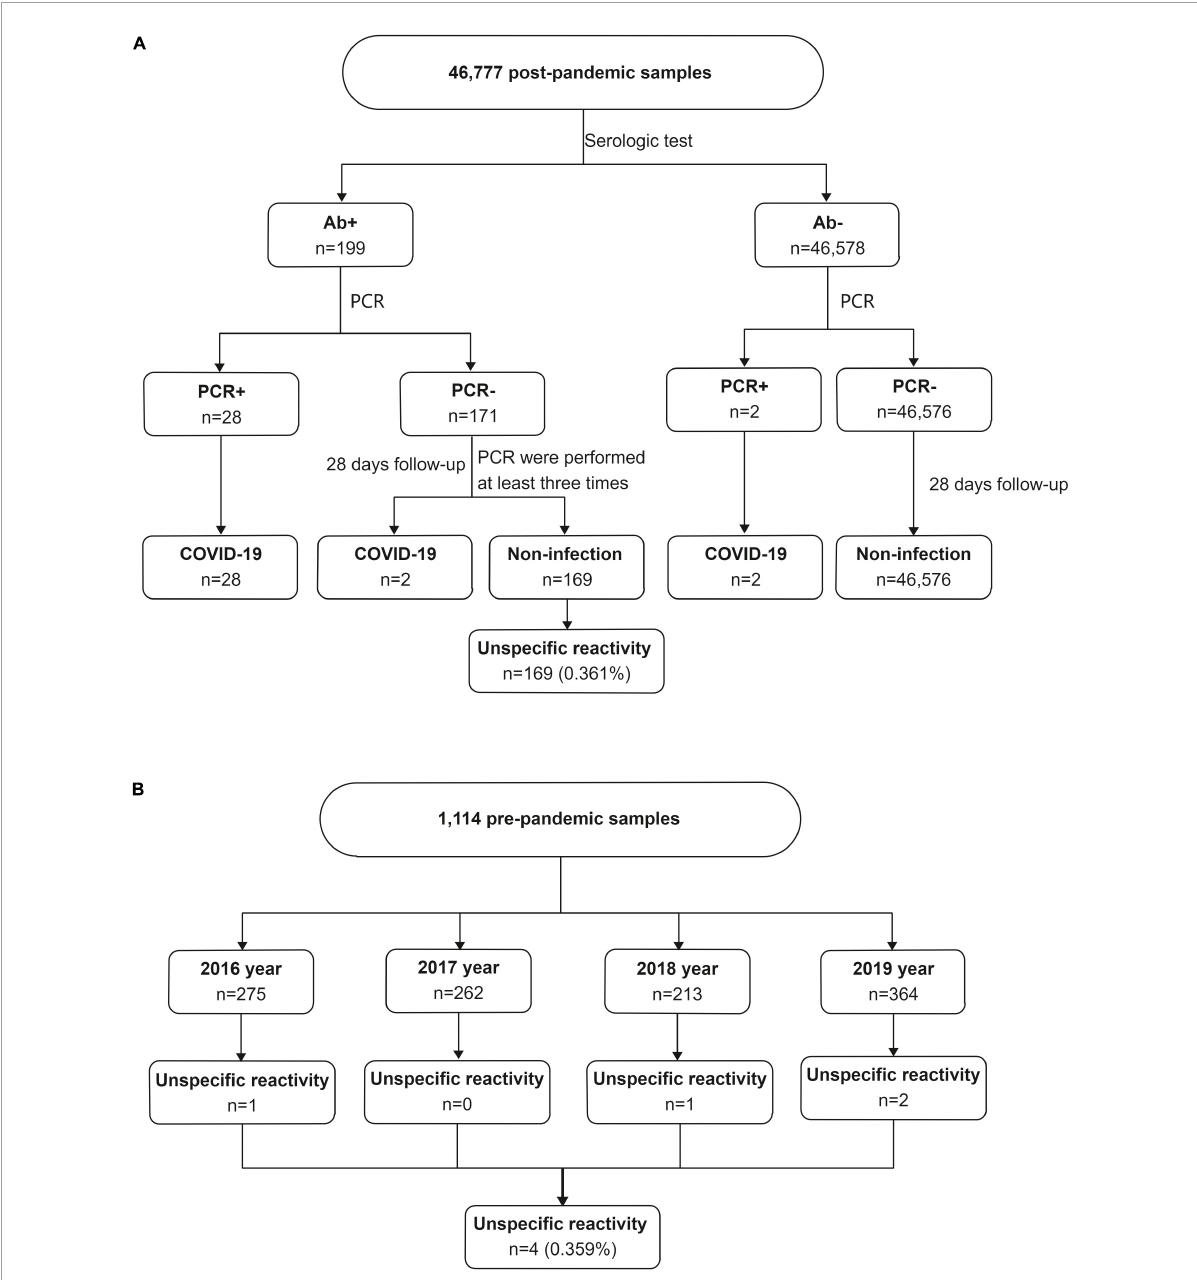
FIGURE1 The unspecific reactivity in anti-SARS-CoV-2 total antibody testing. (A) The unspecific reactivity in 46,777 post-pandemic subjects who were screened for SARS-CoV-2 infection, (B) the unspecific reactivity in 1,114 pre-pandemic frozen serum samples. Ab, total anti-SARS-CoV-2 antibody; PCR, polymerase chain